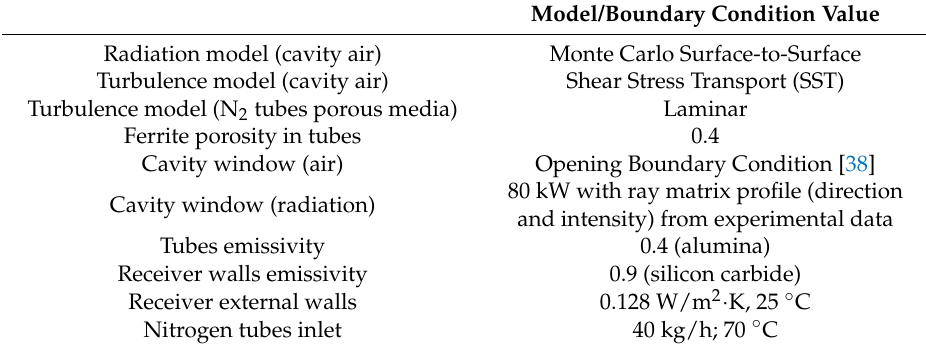
Table 1. Physical models and boundary conditions used in the CFD (Computational Fluid Dynamics)